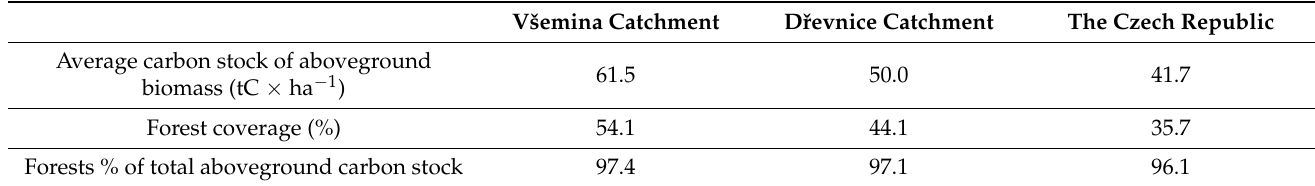
* Values were calculated according to Equations (1) and (2). Table 4. Contribution of forests’ total aboveground carbon stock (according to Detailed Com- bined Layer).